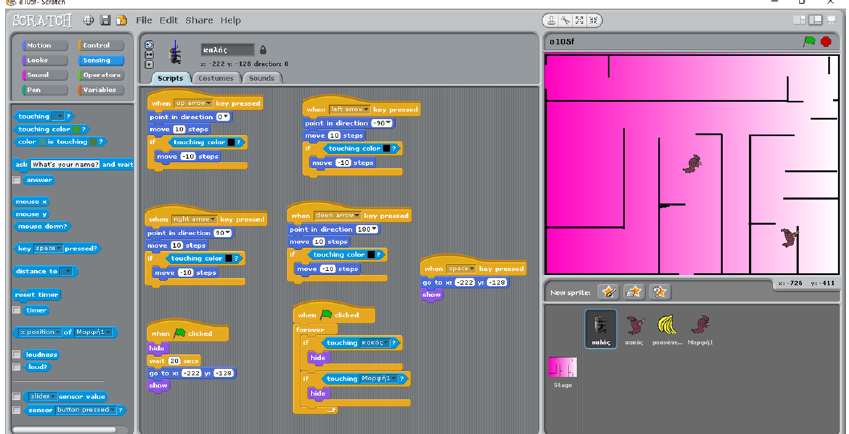
Fig. 1. Example of a final project by an average performing fifth grade student. Three sprites and a thesaurus exist (bananas). The hero sprite (elephant) is controlled by 7 scripts. It can be observed that two scripts execute when green flag is pressed. The initialization correctly uses time based synchronization (wait 20 secs) but is not completely correct (the two scripts should have been combined into